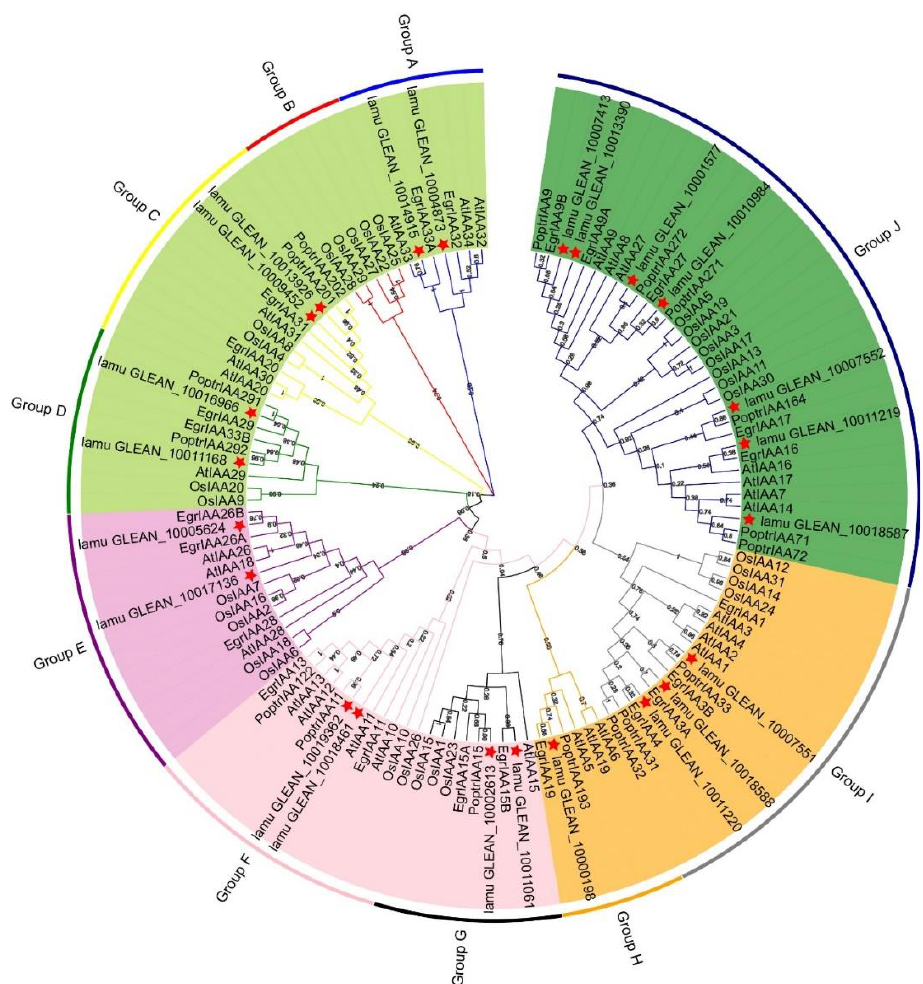
Figure 3. Phylogenetic tree of the Aux/IAA proteins family for M. oleifera , A. thaliana , O. sativa , P. trichocarpa , and E. grandis . The phylogenetic tree was constructed with 1000 bootstrap replications in MEGA7.0. Five colors represent the five subfamilies, and a red star indicates MoIAAs. Table 2. Analysis of Ka/Ks for the MoIAAs.